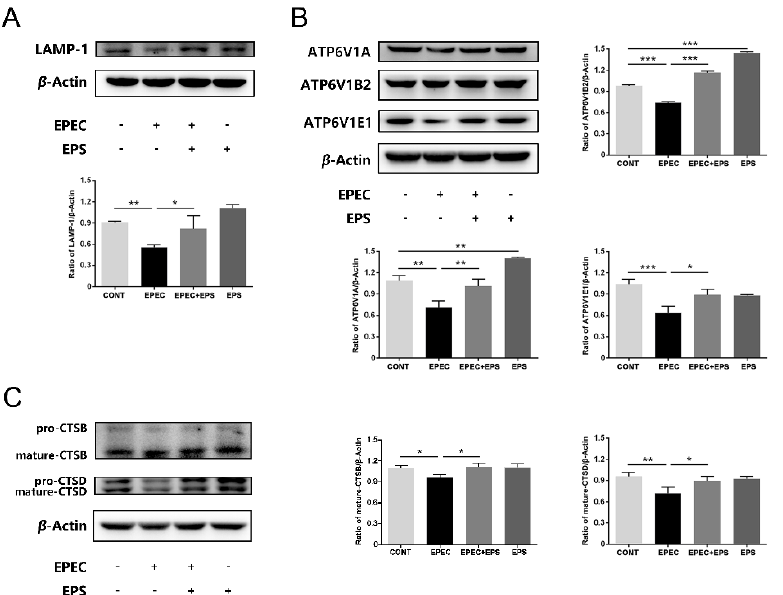
Figure 5. EPS alleviated lysosomal damage caused by EPEC in IPEC-J2 cells. ( A ) Western blot analysis for the protein expression levels of LAMP-1. ( B ) Western blot analysis for the protein expression levels of ATP6V1A, ATP6V1B2, and ATP6V1E1. The panel below showed the quantitation analysis by Image J software. ( C ) Western blot analysis for the protein expression levels of CTSB and CTSD in IPEC-J2 cells and the right panel was the quantitation analysis by Image J software. The data was presented as mean ± SEM ( n = 3), * p < 0.05, ** p < 0.01, *** p < 0.001.